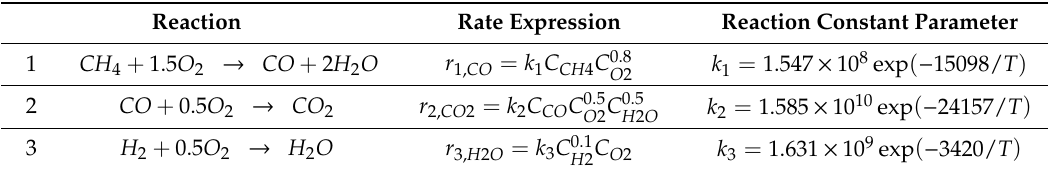
Table 1. Syngas combustion key reaction steps, rate law expression, and reaction constant parameter as function of temperature T implemented in the PFR.